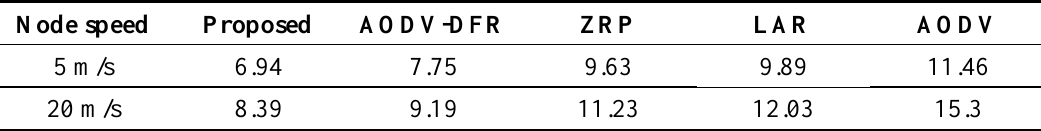
Table 3. Average number of control messages per delivered